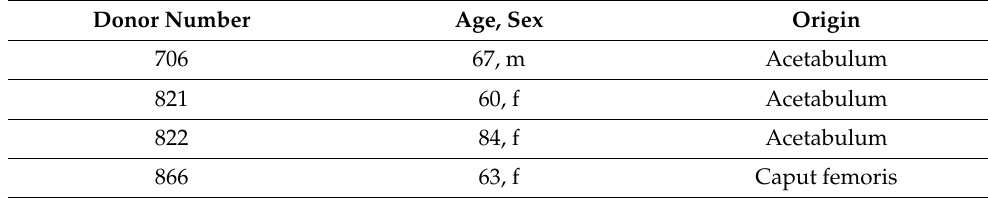
Table 2. BMSC origin, m = male, f =